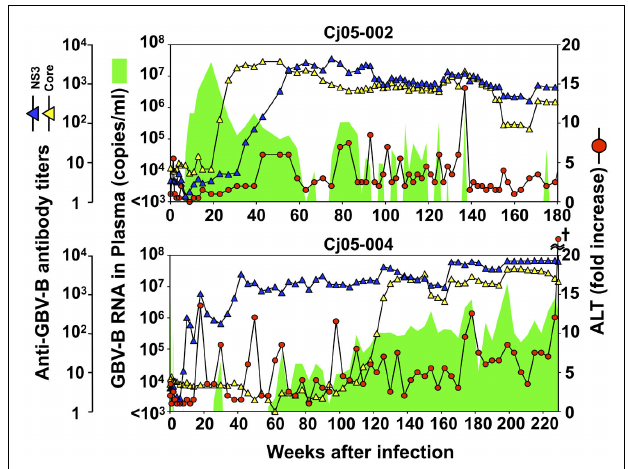
FIGURE 2 | Profiles of the marmosets persistently infected with GBV-B. Plasma samples periodically obtained from the marmosets were evaluated for the copy numbers of GBV-B genomic RNA (green shaded area), ALT levels (red circles), and the antibody titers against GBV-B core and NS3 (blue and yellow triangles, respectively).The cruciate mark in Cj05-004 indicates that the individual was euthanized due to a poor prognosis at week 229 p.i. At that time, the ALT value in plasma had increased by